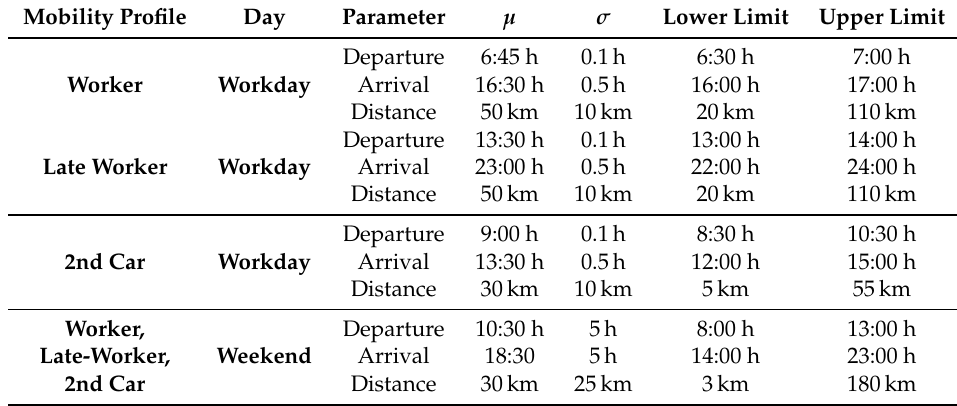
Table 2. Parameters of the normal distributions and limits for the mobility parameters departure time, arrival time, and driving